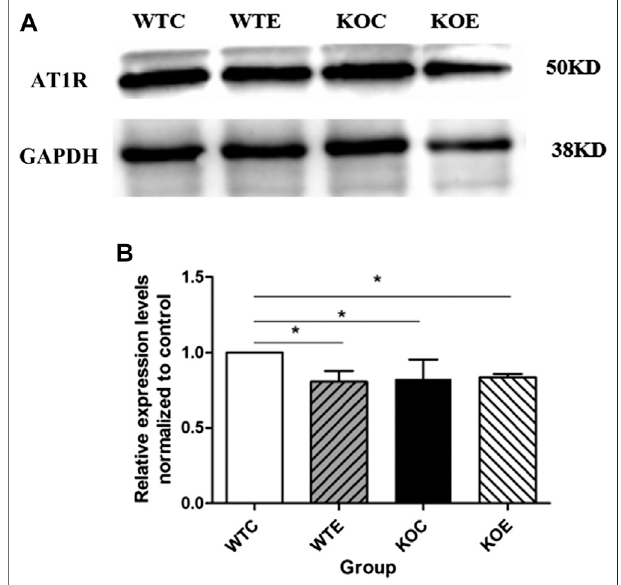
FIGURE 6 | Western Blotting Results of AT1R 6 – 8 weeks C57/B6 mice, with or without Nrf2 knockout were exposed to either fi ltered air or air containing particulatematter (PM) for six weeks, and then the vascular tissues were collected, embedded in paraf fi n, extracted and subjected to westernblottingforAT1R.N (cid:2) 4pergroup.*:statisticallydifferentbetweenthe twogroups( p < 0.05). (A) :TheexpressionlevelofAT1Rinvasculartissue. (B) : Quanti fi cation of the AT1R